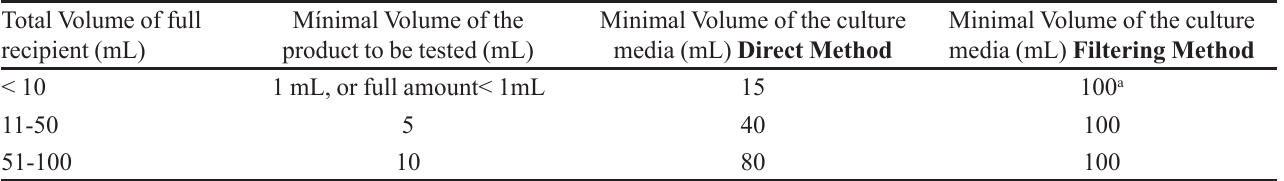
TABLE III - Correlation between the sample volumes and culture media in the direct and indirect (membrane filtering)